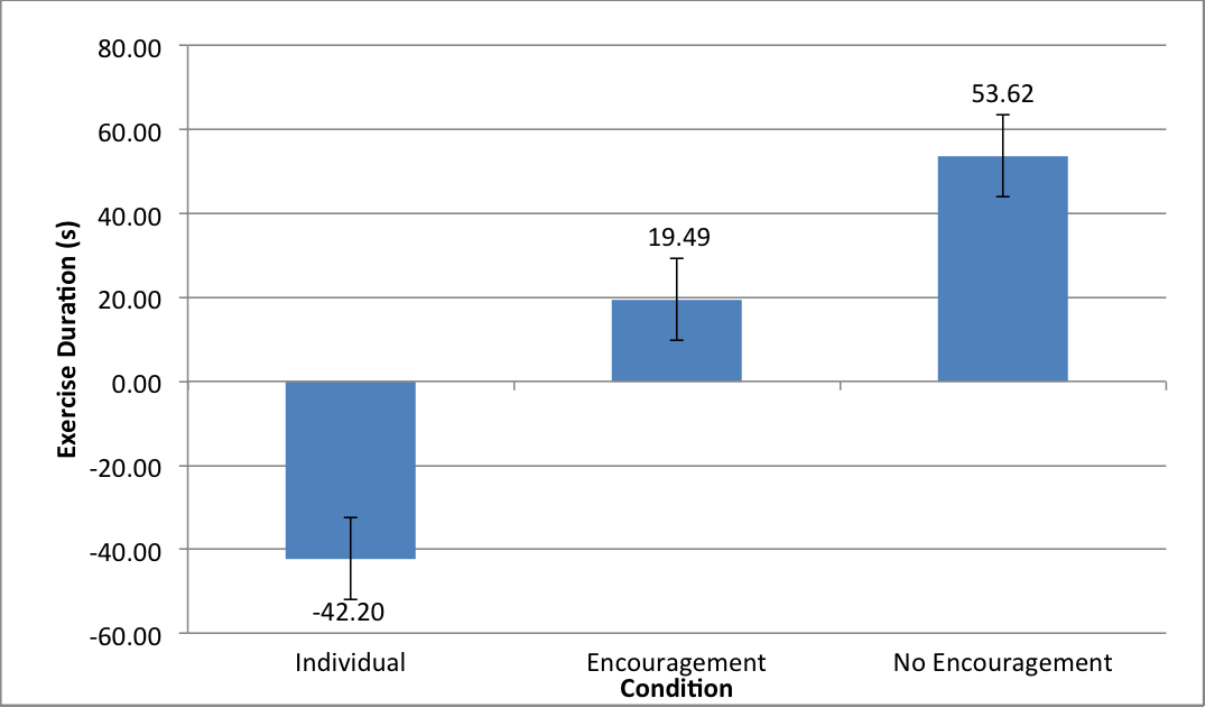
Figure 2. Condition Block 2 - Block 1 exercise duration